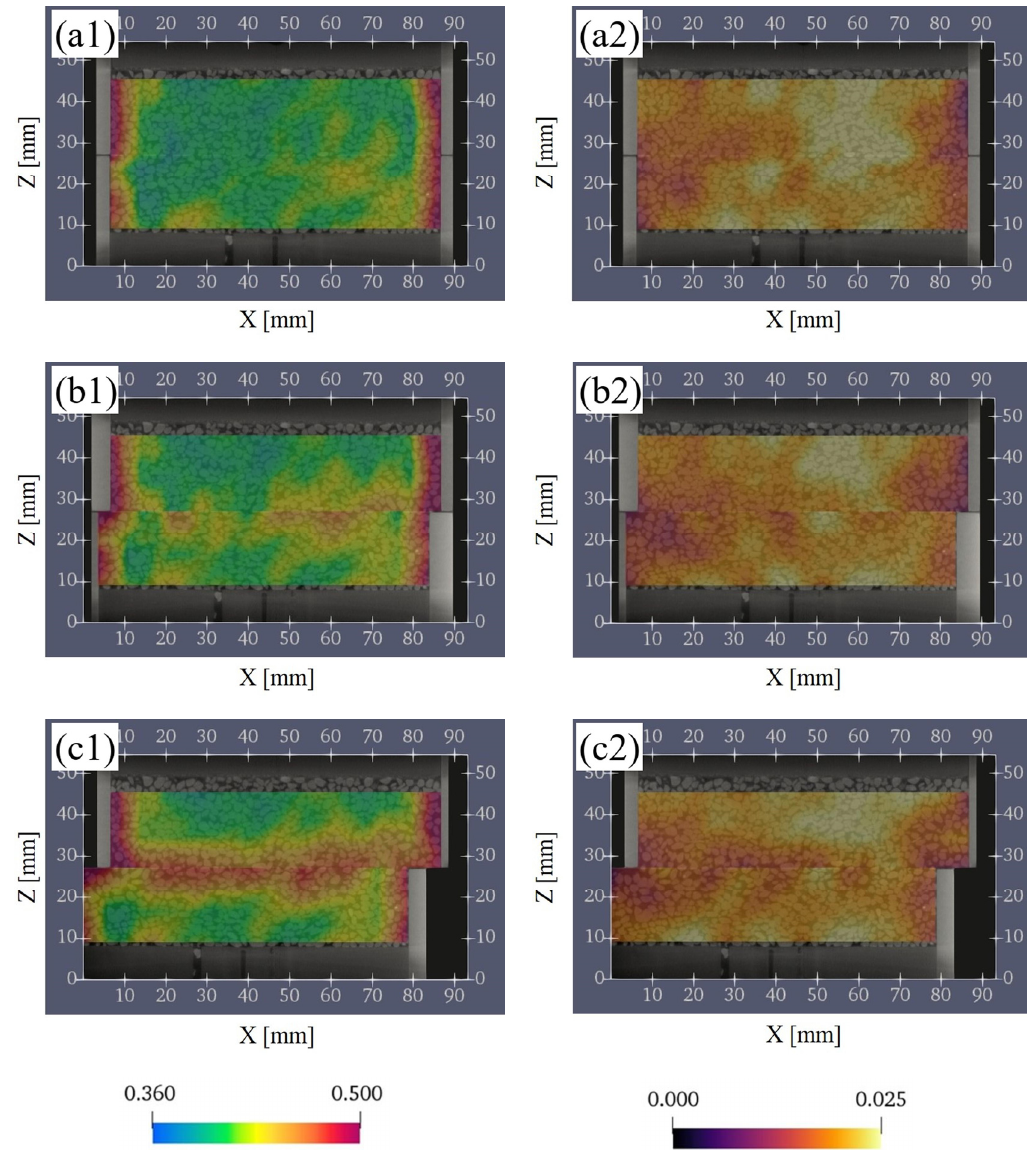
Figure 11. Evaluation results of the porosity and the ratio of contact-surface between particles on the vertical plane (XZ plane). ( a1 , a2 ) are the results at S0 (initial sate). ( b1 , b2 ) are the results at S2 (D h = 3.0 mm). ( c1 , c2 ) are the results at S4 (D h = 8.0 mm). D h , horizontal displacement. The left columns are the porosity, and the right columns are the ratio of contact-surface between particles.